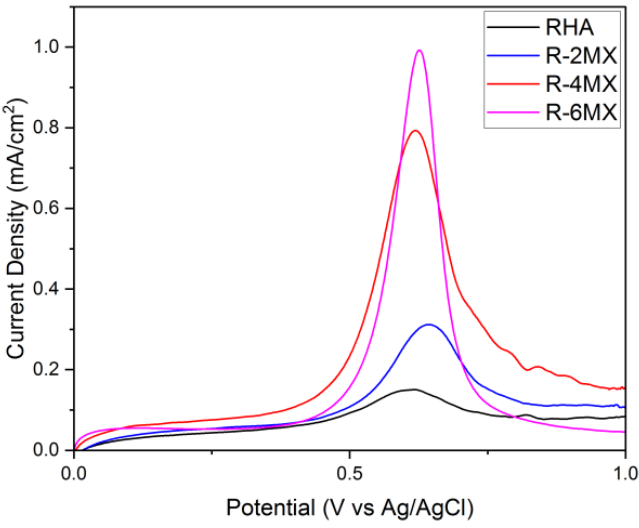
Figure 5. LSV analysis, current density against the potential of different composites of R-MX.